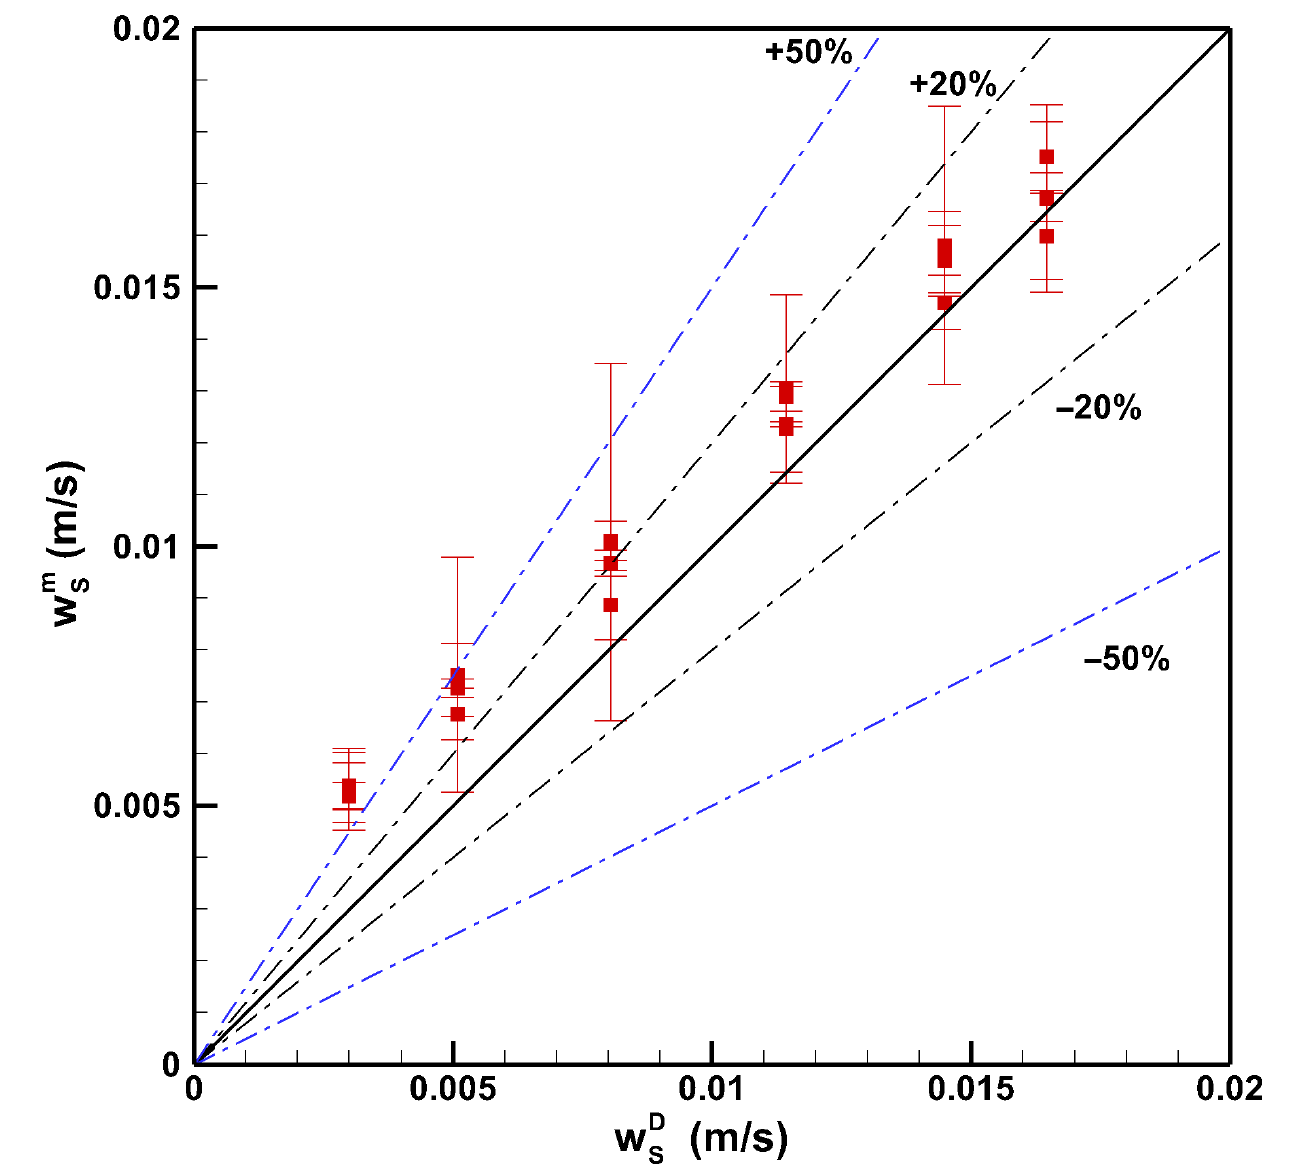
Figure 7. Comparison between the measured net settling velocity against the theoretical settling velocity as in Dietrich (1982). Rectangles are the mean of the measured settling velocities with their standard deviation; the black solid line is the plane bisector, indicating perfect agreement, whereas the black and the blue dotted-dashed lines represent the ± 20% and ± 50% confidence intervals,